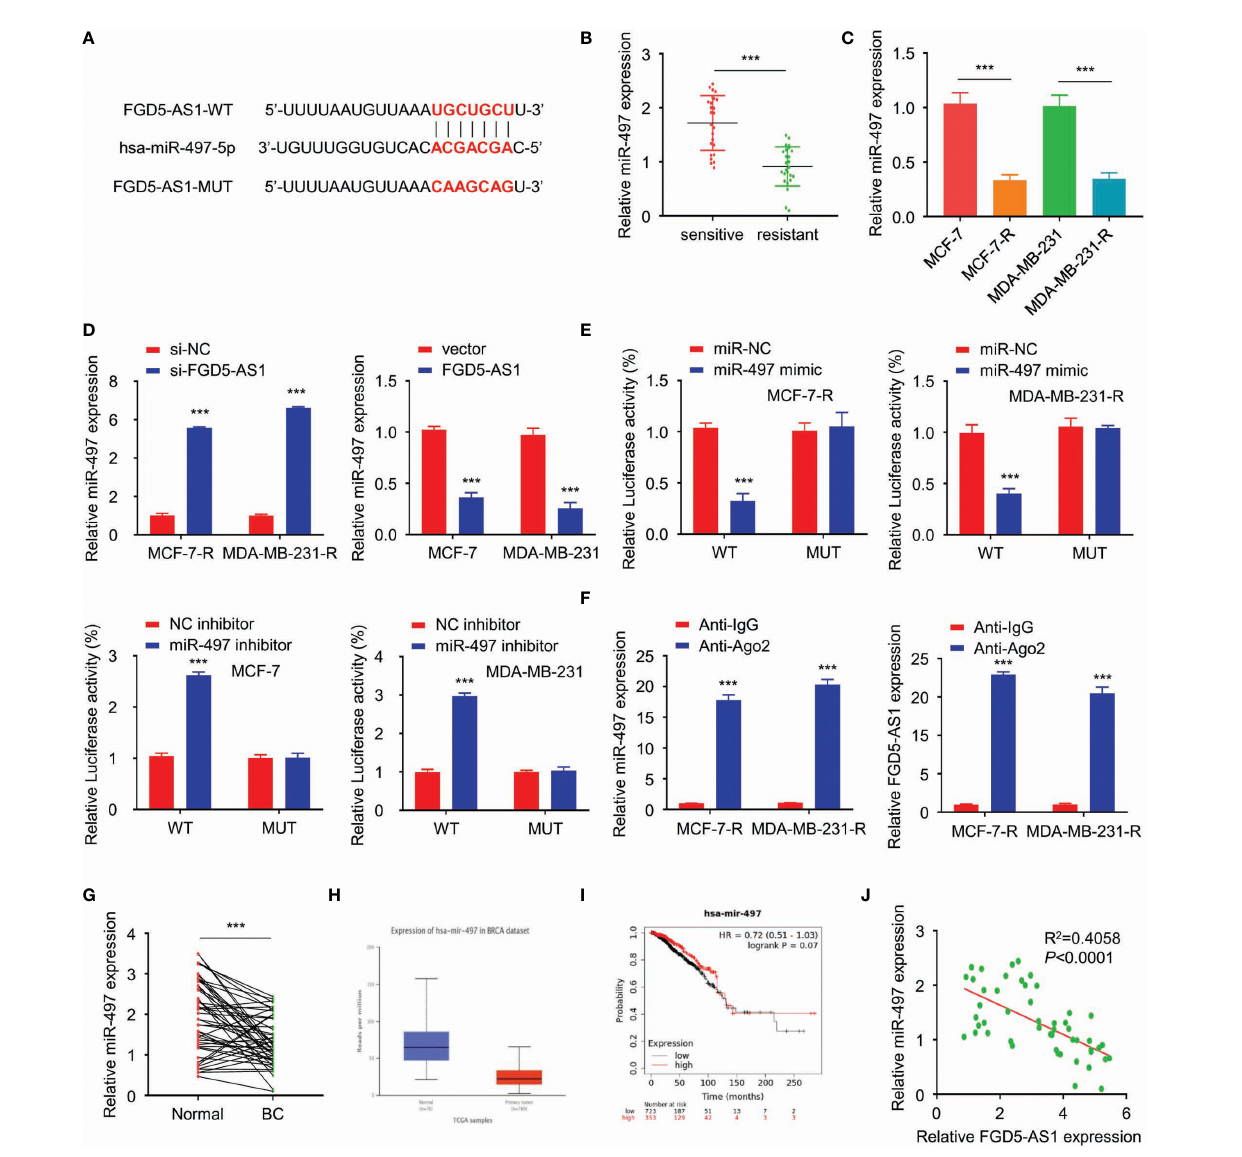
FIGURE 4 | FGD5-AS1 directly binds to miR-497-5p and suppresses its expression in BC cells. (A) Using the starBase database to predict the binding site of miR-497-5p in the FGD5-AS1 sequence. (B) qRT-PCR assays showed that miR-497 expression was signi fi cantly decreased in the radio-resistant BC tissues group (n=25). (C) qRT-PCR assays indicated the lower levels of miR-497 in MCF-7-R or MDA-MB-231-R cells than MCF-7 or MDA-MB-231 cells. (D) Using qRT-PCR assays revealed that FGD5-AS1 exogenous expression signi fi cantly reduced the expression of miR-497. Meanwhile, FGD5-AS1 silencing signi fi cantly upregulated the expression of miR-497. (E) Using the luciferase reporter assays, miR-497 mimic signi fi cantly reduced the luciferase activity of the pGL3-FGD5- AS1-WT and FGD5-AS1-MT cell were had not been affected. In contrast, miR-497 Inhibitor signi fi cantly promoted the luciferase activity of the pGL3-FGD5-AS1- WT, as the same, FGD5-AS1-MT cell were had not been affected. (F) RNA binding protein immunoprecipitation against Ago2 indicated that FGD5-AS1 or miR- 497 were signi fi cantly enriched in Ago2 pellets. (G) qRT-PCR assays showed that miR-497 levels were signi fi cantly downregulated in BC tissues. (H) UALCAN database indicated the signi fi cant downregulation of miR-497 in TCGA BC tissues (P<1E-12). (I) KM plotter showed that lower miR-497 expression was signi fi cantly correlated with worse survival in BC patients. (J) PCR showed a negative relationship between FGD5-AS1 and miR-497 expression levels in BC tissues (n=50). Intra-group comparison ***p <